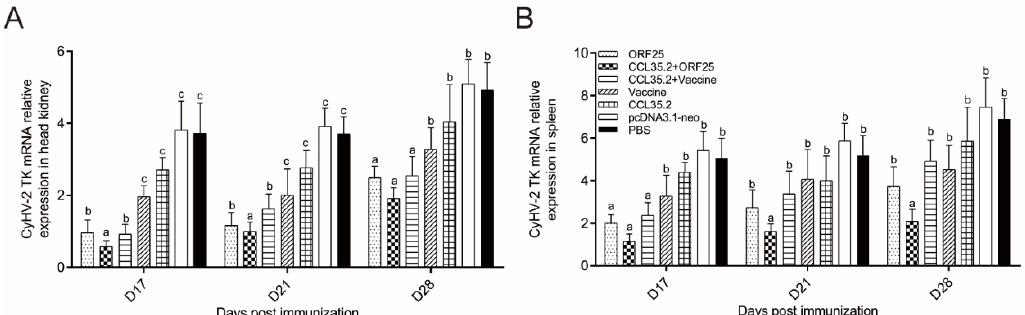
Figure 10. mRNA expression profiles of TK in head kidney ( A ) and spleen ( B ). They were determined by qRT-PCR. β -actin gene was used as a reference gene. Di ff erent superscript letters in each group (a–c) denote significant variations suggested by the Kruskal–Wallis statistics at 95% of significance, followed by the Dunn test with Bonferroni adjustment as the post hoc test ( p <